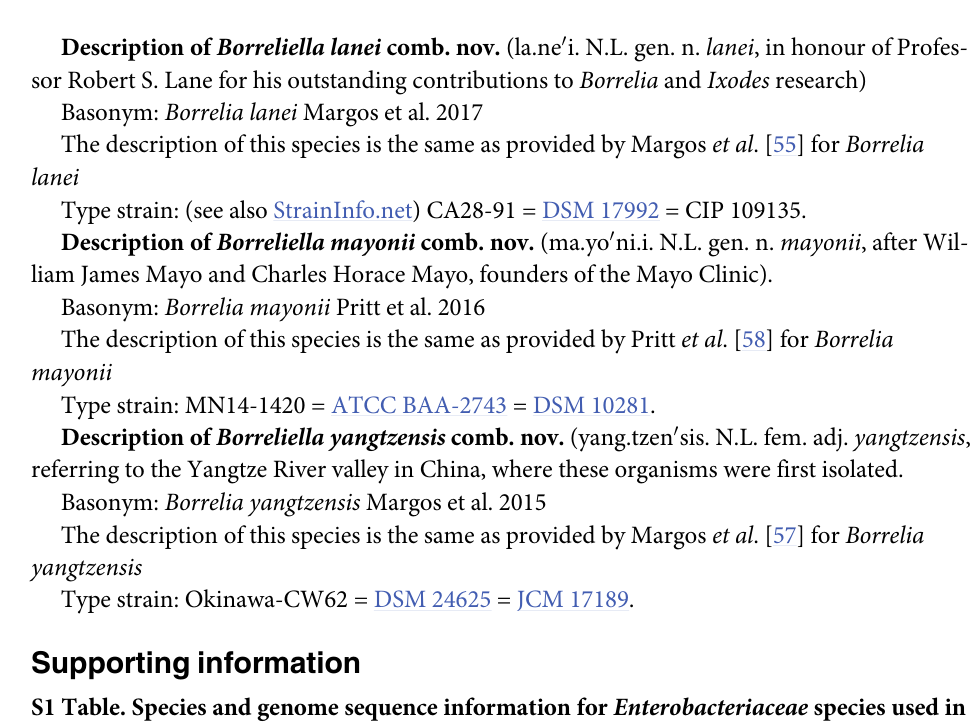
S1 Table. Species and genome sequence information for Enterobacteriaceae species used in POCP analysis. S2 Table. Species and genome sequence information for Morganellaceae and Cystobactera- ceae species used in POCP analysis. S3 Table. Averages of the intrageneric and intergeneric POCP values for species from the family Morganellaceae and Cystobacteraceae